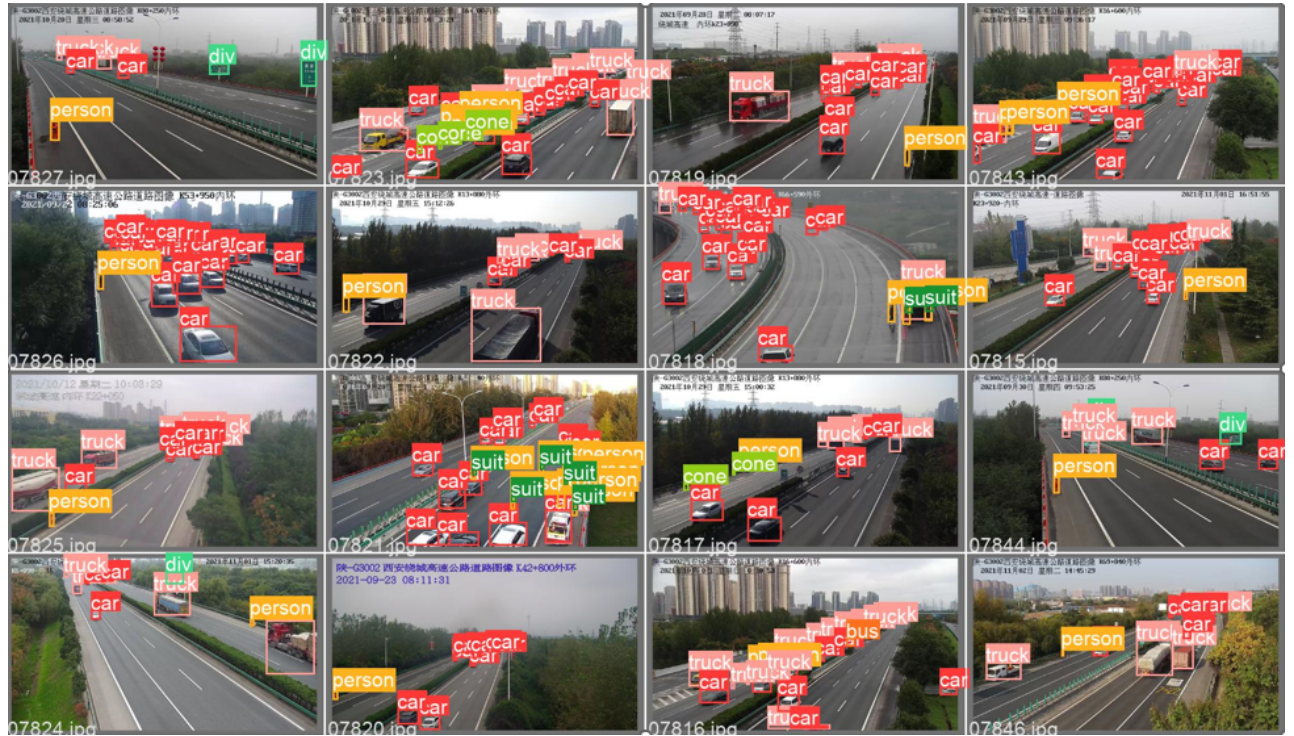
Figure 10. Detection results of the multi-scale YOLOv5s algorithm. (The Chinese words in the image are the time and place recorded by the surveillance